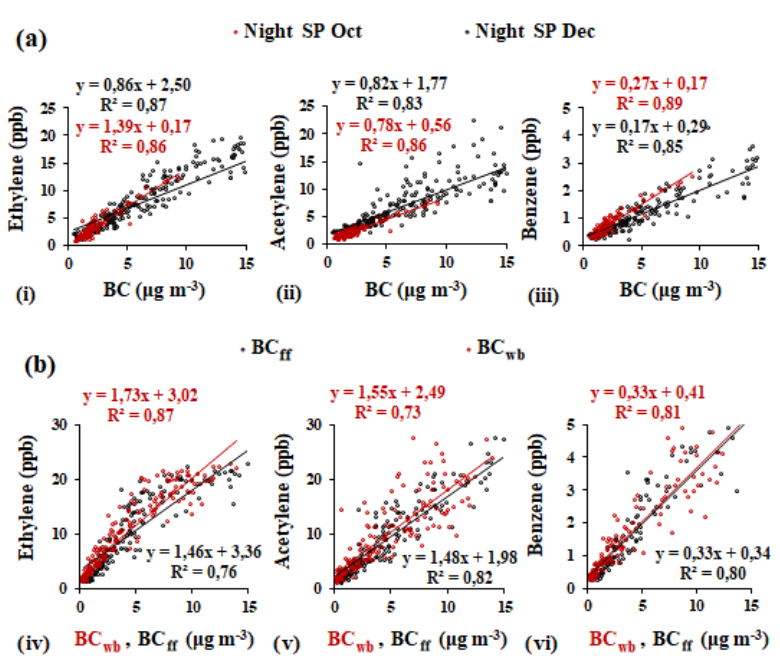
Figure 12. Regressions between ethylene, acetylene and benzene (a) against BC (i–iii) for the nighttime (18:00–05:00LT) SPs in October and December 2015 and (b) against BC wb (red) and BC ff (black) for the nighttime (22:00–04:00LT) SP in December